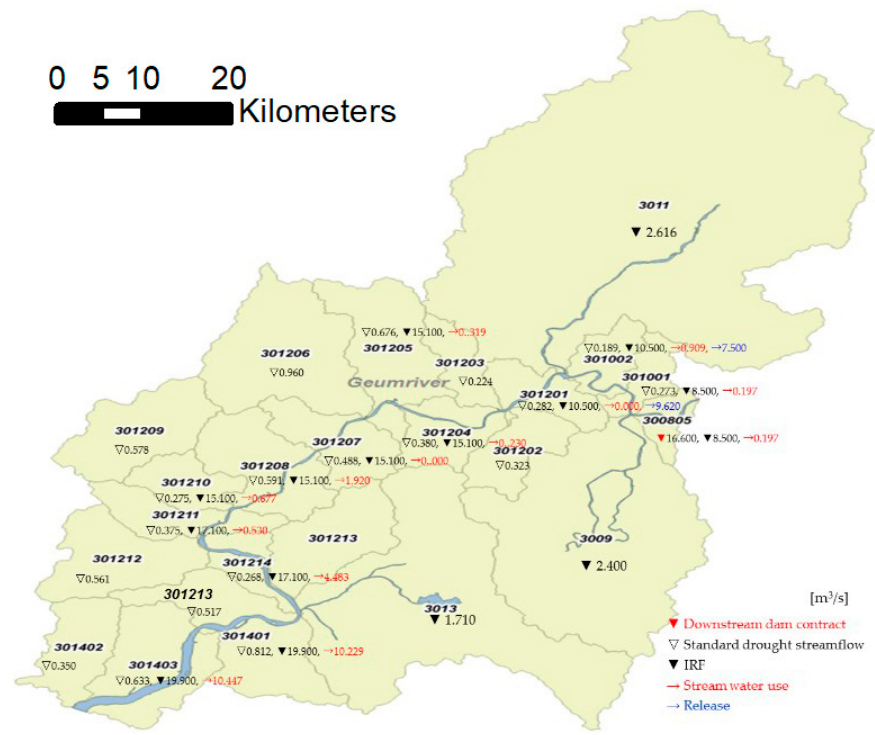
Figure 9. Status of the Geum River for RMF calculation.